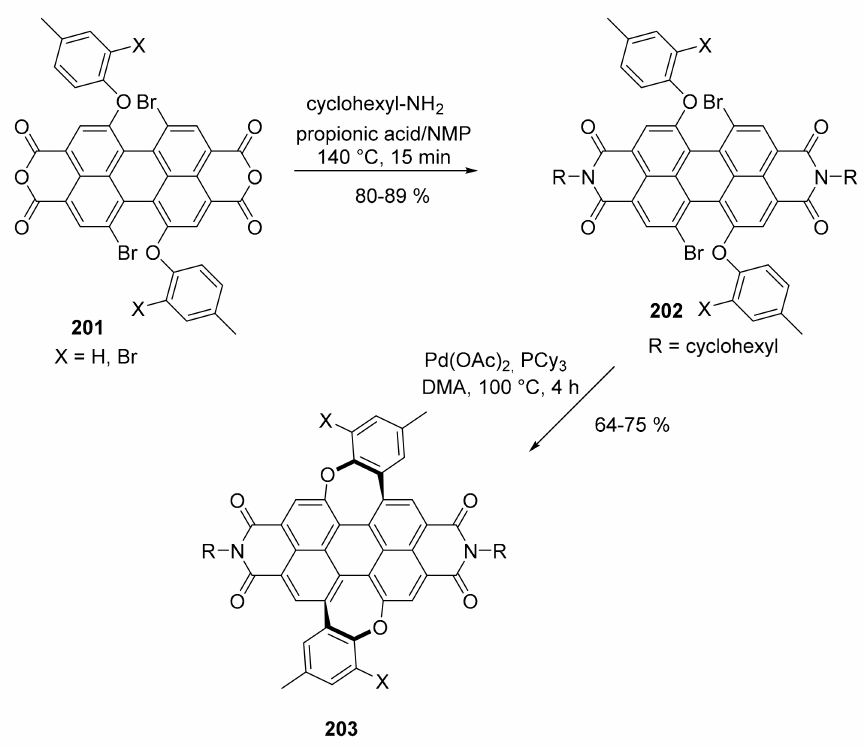
Scheme 43. Synthesis of compound 203